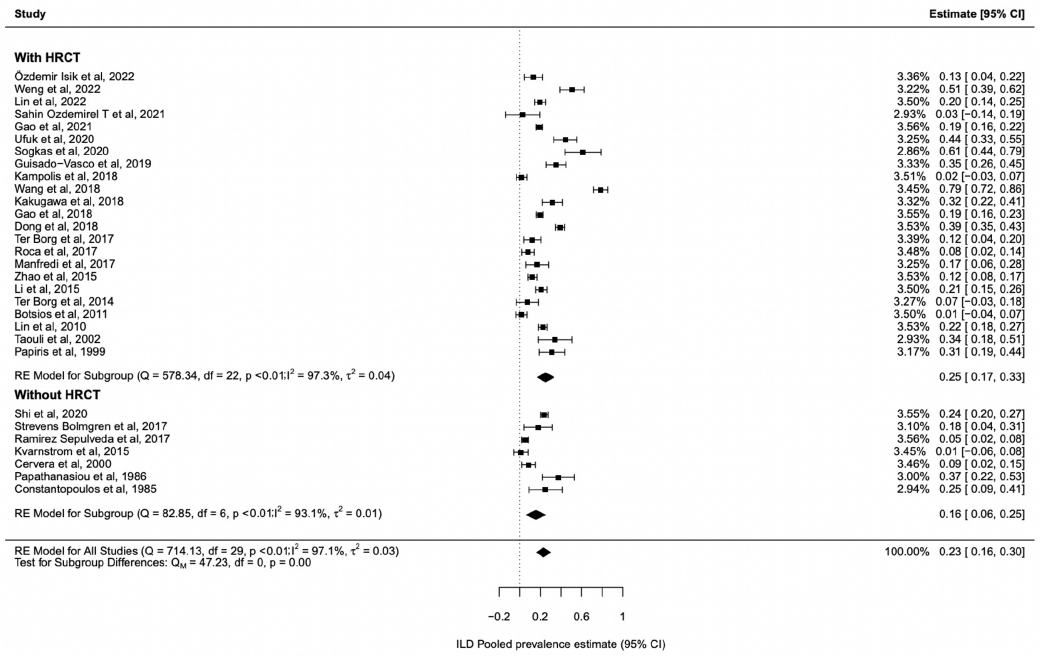
Figure 2. Forest plots depicting the pooled prevalence estimate for ILD in Sjogren patients with subgroup analyses for HRCT. Diamonds indicate the overall summary estimates, and width of the diamonds represents the 95% confidence interval (CI); boxes indicate the weight of individual studies in the pooled results [17–19,21–46].